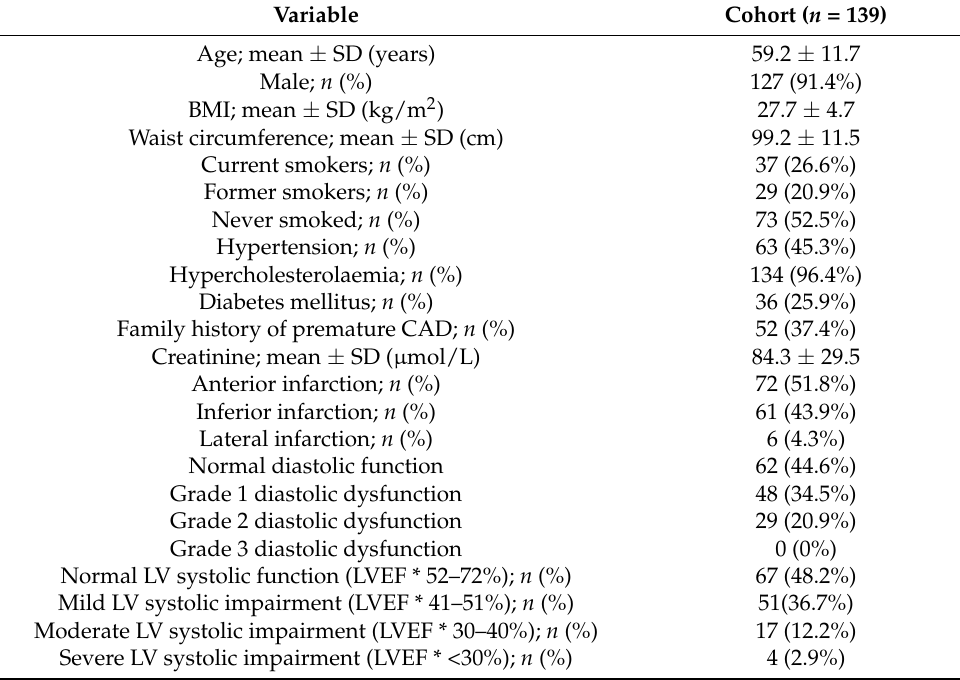
Table 1. Baseline clinical